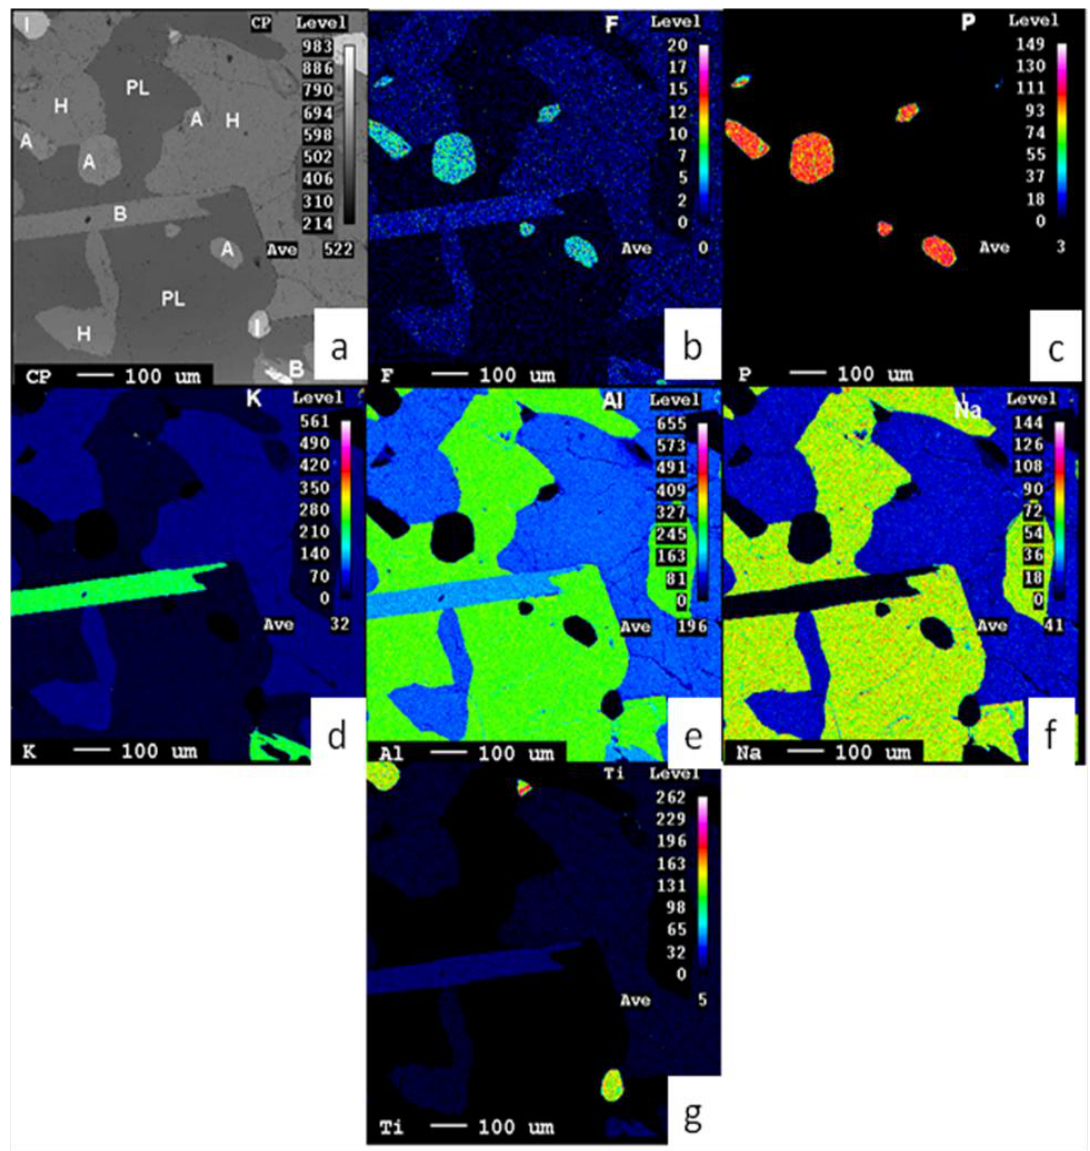
Figure 6: (a) Back scattered electron image (BSE) showing different minerals; apatite (A), biotite (B), hornblende (H), plagioclase (PL) and ilmenite (I). (b-g) EDS X-ray images showing relative abundance of elements proportional to brightness. Fluoride (F), phosphorus (P), potassium (K), aluminum (Al) sodium (Na) and titanium